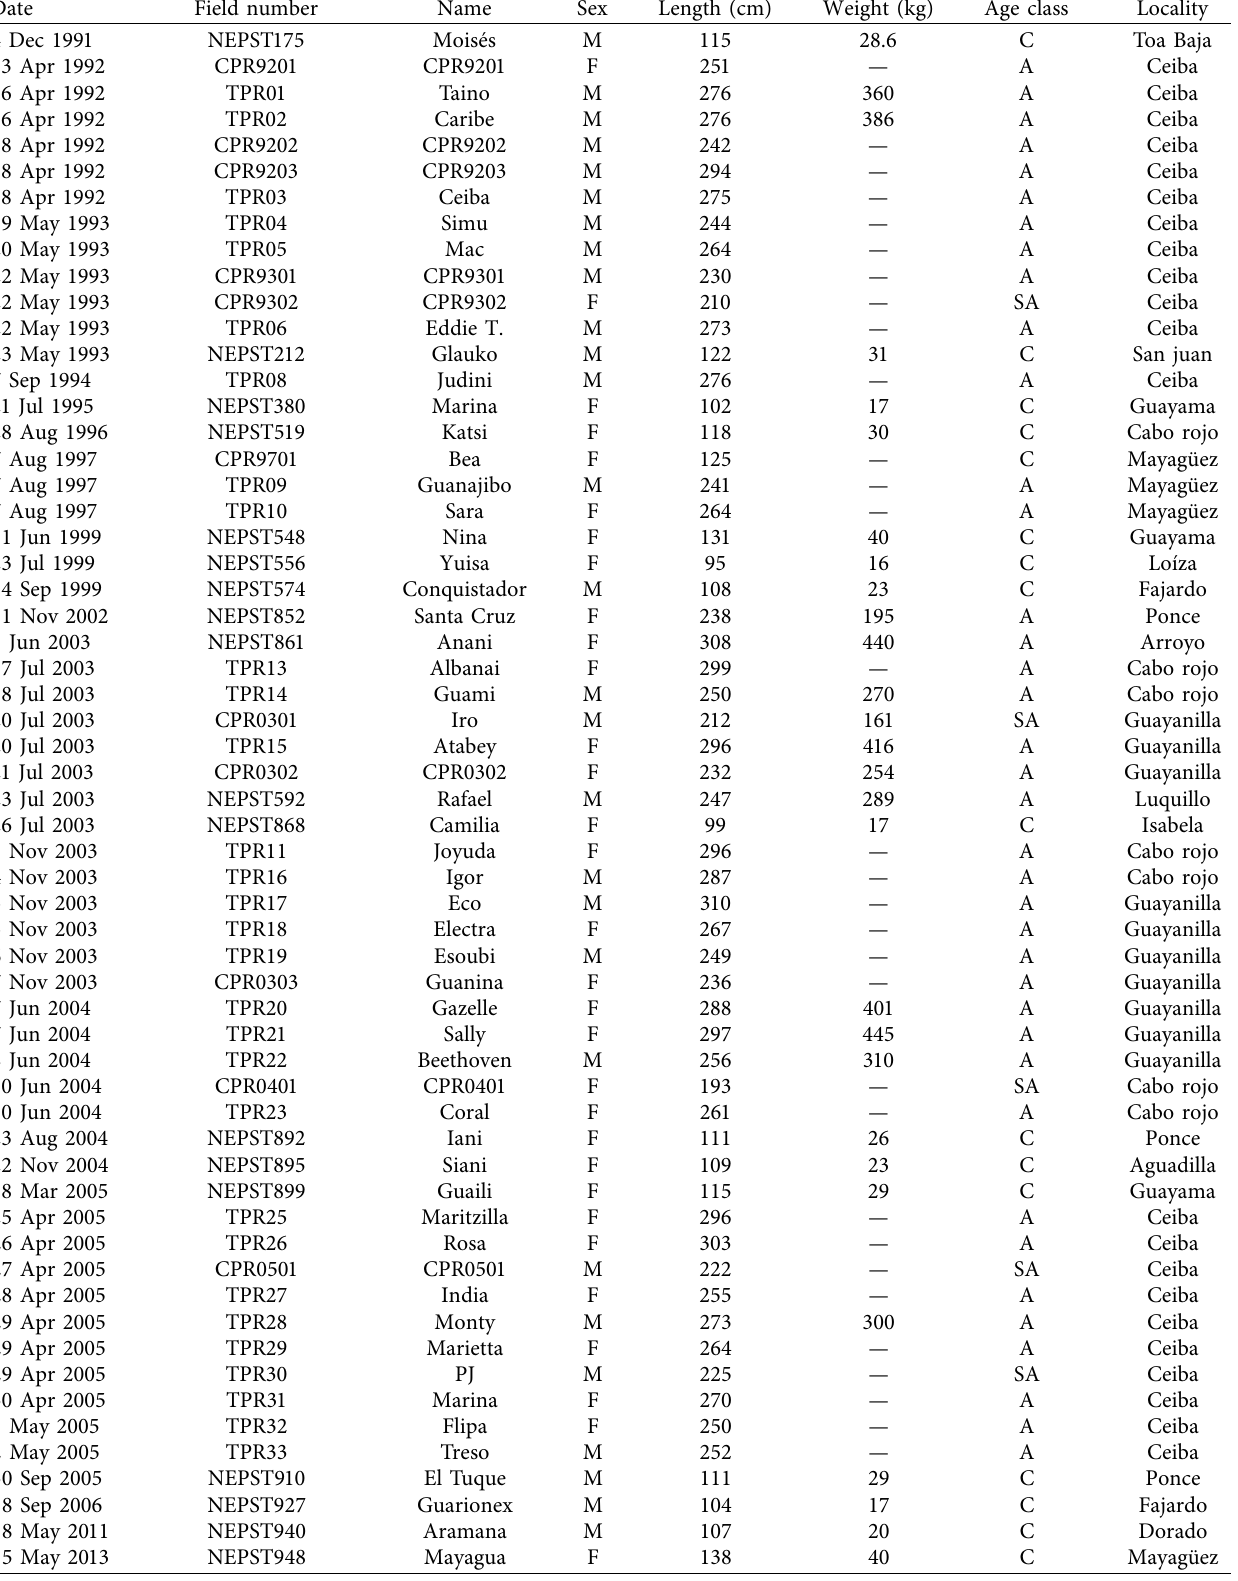
Table 1: Antillean manatees sampled in Puerto Rico for this study, including those free-ranging and those rescued and in rehabilitation between 1991 and